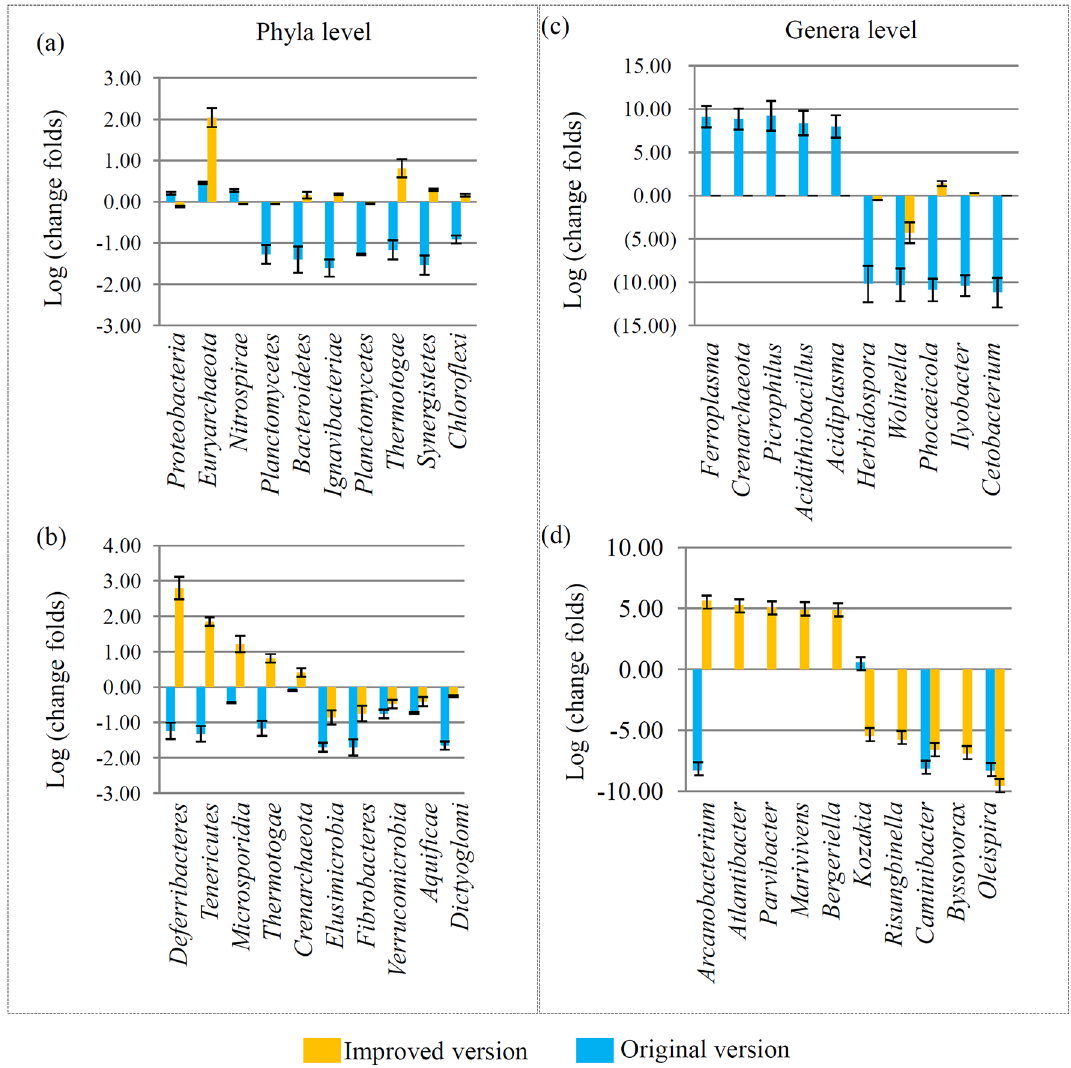
Figure 5. Comparison of the microbial community between original and improved biofilters. ( a ) Changes in microbial communities of the top 10 phyla that were significantly changed in the original biofilter. ( b ) Changes in microbial communities of the top 10 phyla that were significantly changed in the improved biofilter. ( c ) Changes in microbial communities of the top 10 genera that were significantly changed in the original biofilter. ( d ) Changes in microbial communities of the top 10 phyla that were significantly changed in the improved